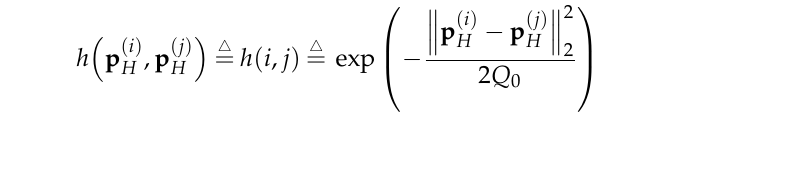
Table 5. Elements and mnemonic names for the high-level player profile (Source: [7,8,14]). Element Mnemonic Quantile Meaning Element Mnemonic Quantile